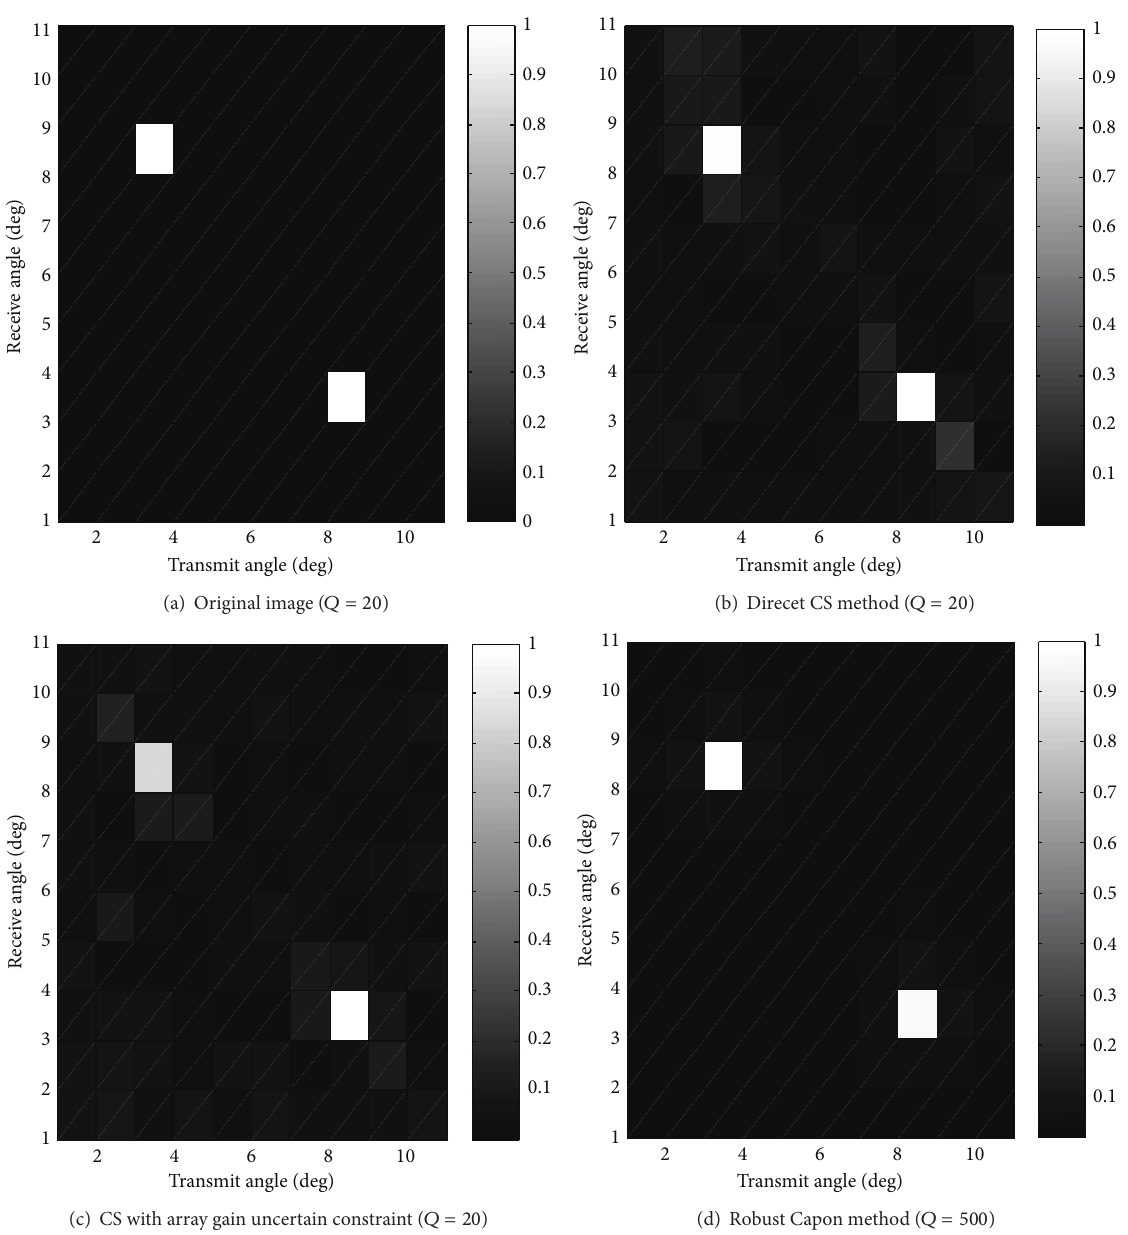
Figure 2: The performance of the proposed method with small array gain uncertain ( 𝑀 = 𝑁 = 20 , [𝜃 𝑡1 ,𝜃 𝑟1 ] = [8 ∘ ,3 ∘ ] , [𝜃 𝑡1 , 𝜃 𝑟1 ] = [3 ∘ , 8 ∘ ] , = 𝜎 = 0.1 𝑄 = 20 , SNR = 10dB, 𝜎 𝑡 𝑟